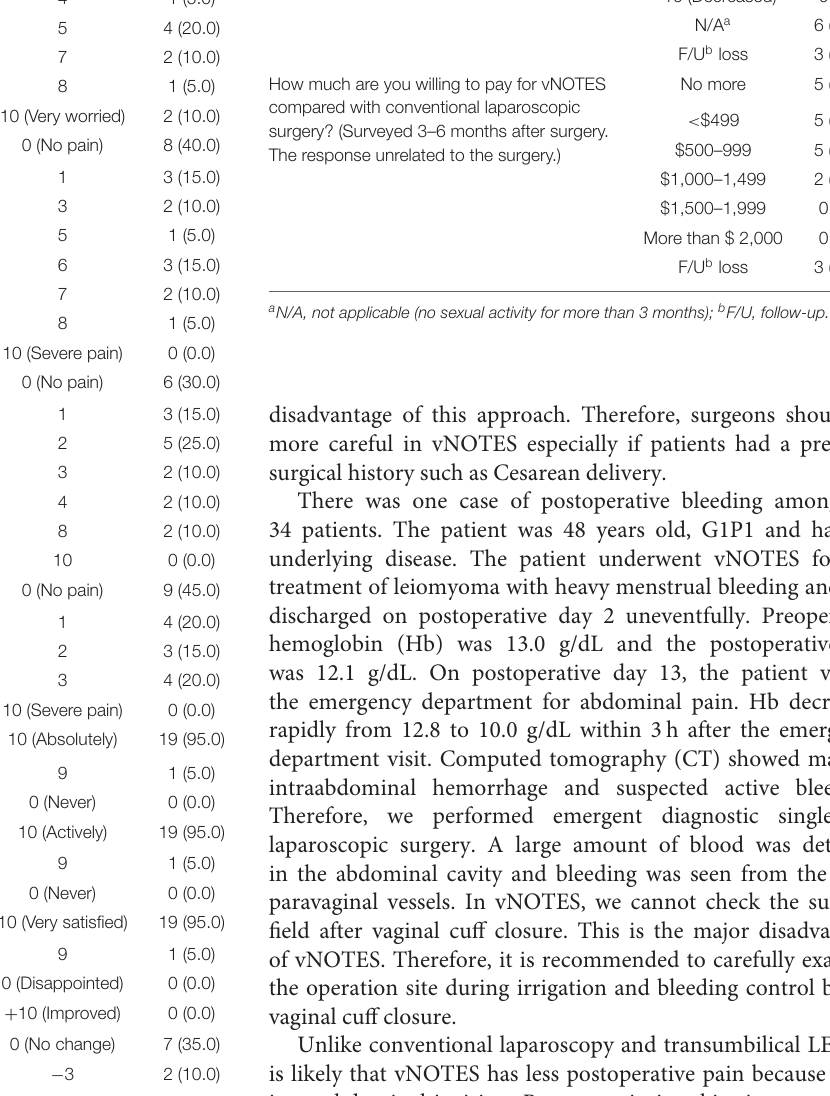
How much are you willing to pay for vNOTES compared with conventional laparoscopic surgery? (Surveyed 3–6 months after surgery. The response unrelated to the